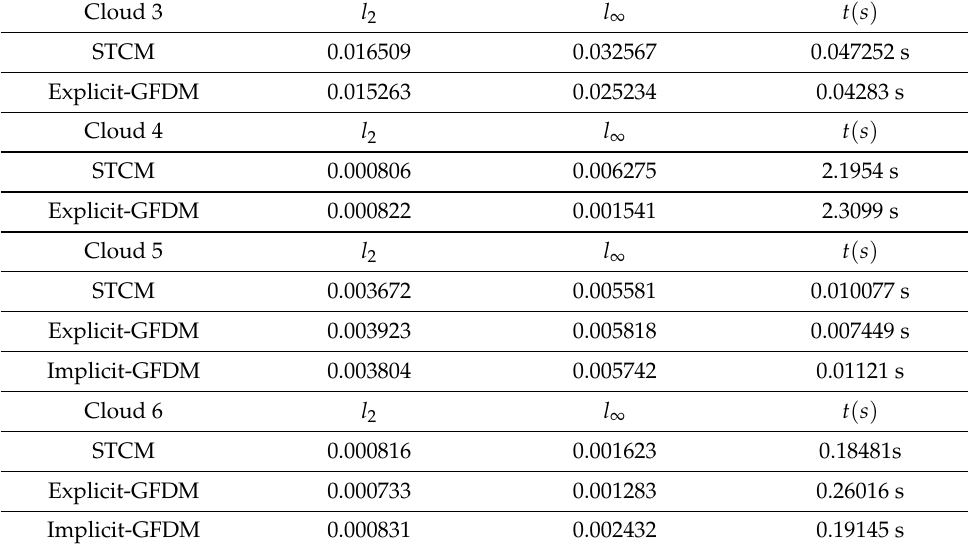
Table 3. Errors and execution time of the Example 3 in the clouds of Figures 5–8.